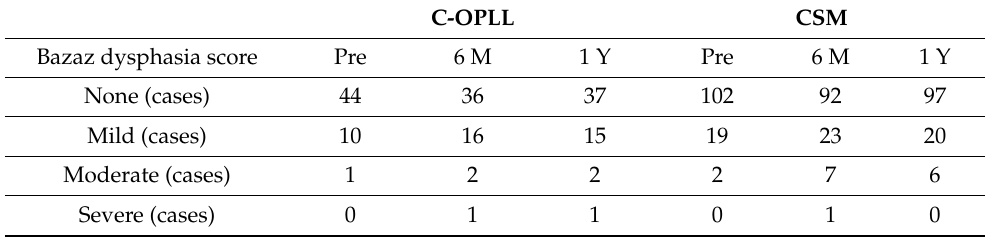
Table 4. Bazaz dysphasia score at each observation point serves to determine the status of dysphagia.